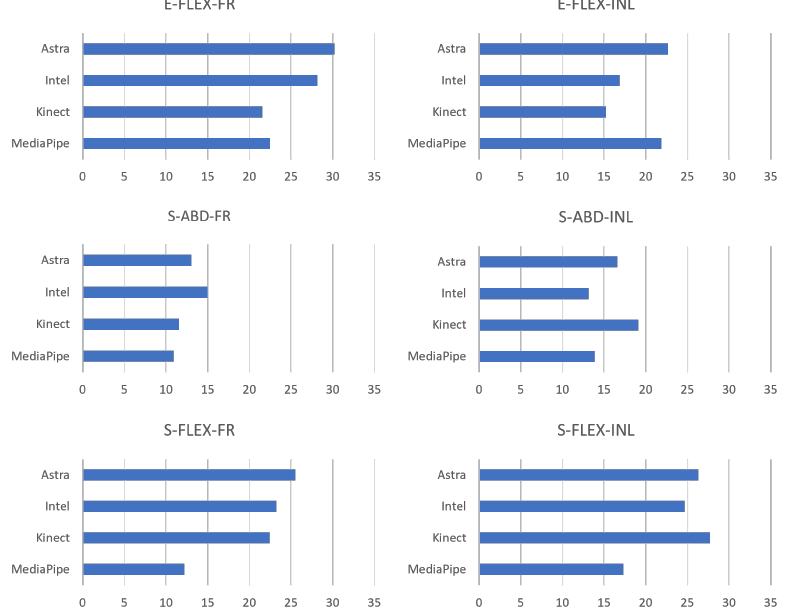
Figure 15. RMS plots of the pooled absolute error (in degrees) for all sensors for UE collection. Additionally, Table 11 expresses the RMS across the movements and the average by comparing the results. MediaPipe obtained the lowest average RMS and